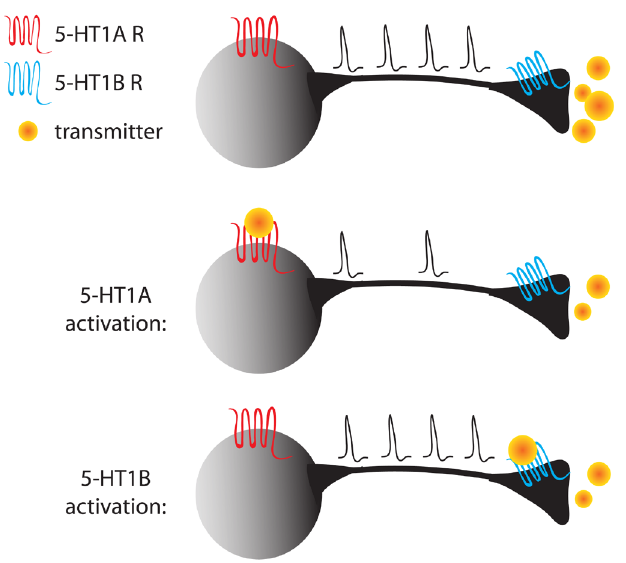
Figure 1. Schematic illustrating the inhibitory effects of serotonin (5-hydroxytryptamine, 5-HT) 1A (5-HT receptors on the normal firing and neurotransmitter release of a neuron (top). Activation of 5-HT firing (middle), while activation of 5-HT (bottom).